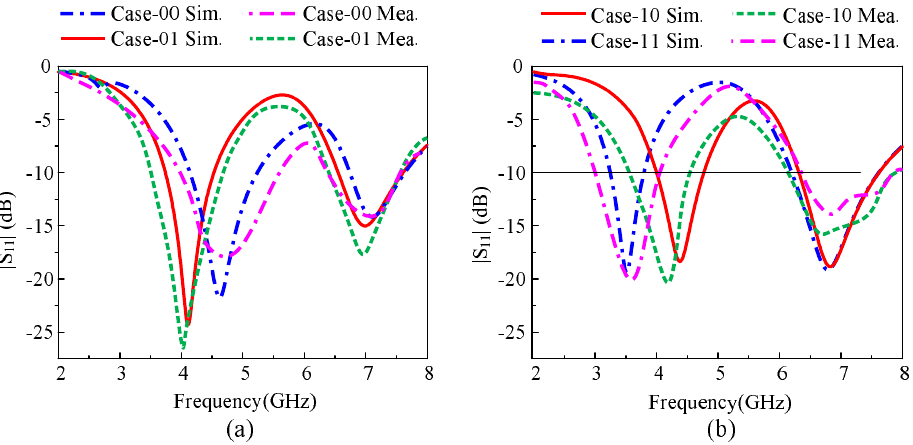
Figure 6. The comparison between measured and simulated reflection coefficient for various switch- ing cases; ( a ) Case-00, Case-01 ( b ) Case-10,